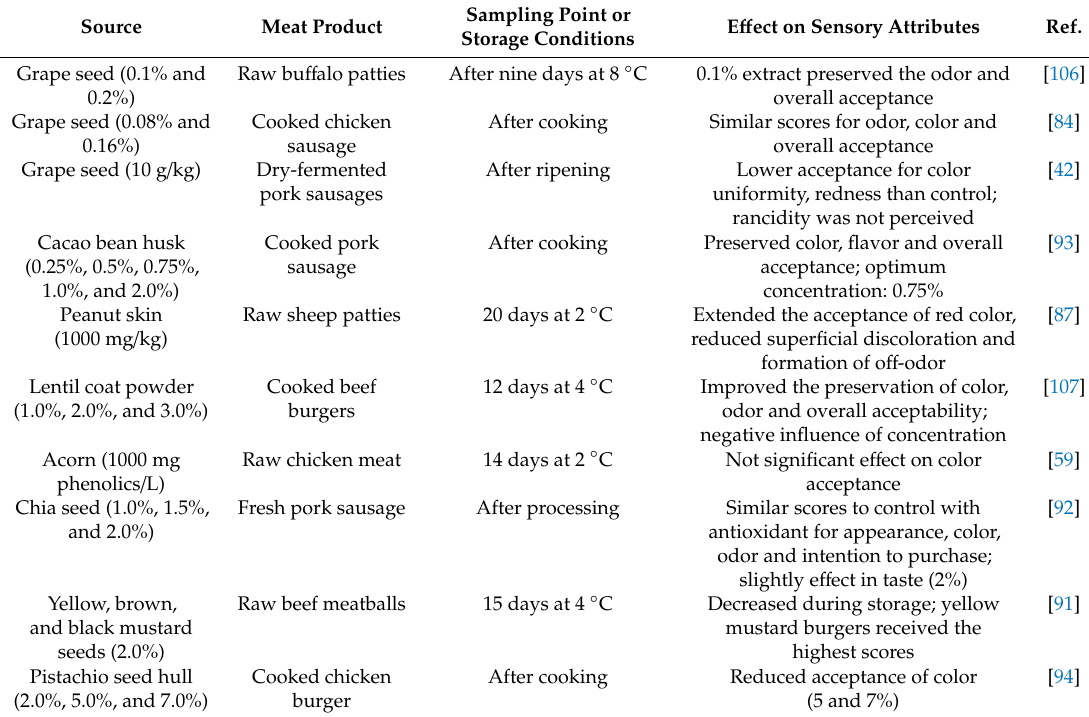
Table 5. Influence of seed extracts on the sensory attributes of meat